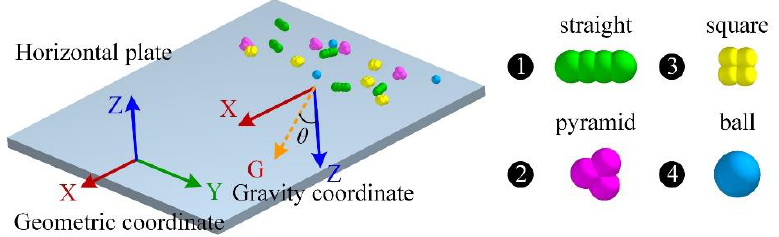
Figure 6. Sliding test in the DEM.